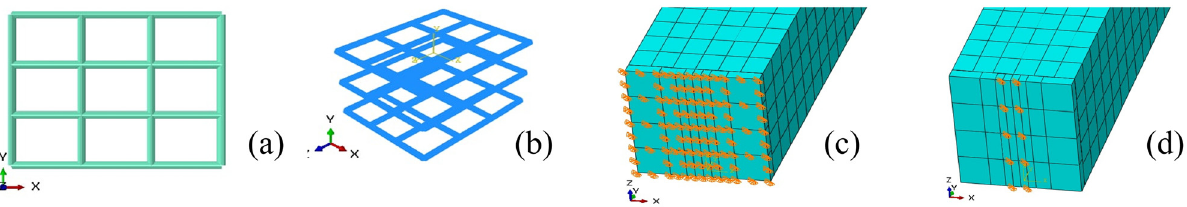
Figure 3: ( a ) Mesh ( part module ) , ( b ) mesh ( assembly module ) , ( c ) whole base pinned, and ( d ) partially restrained base area.